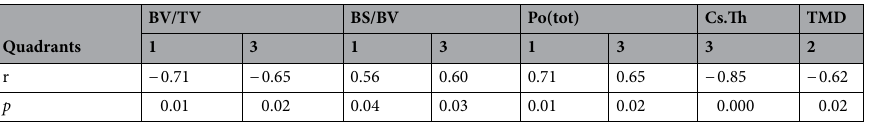
Table 4. Correlation between OA severity and microstructural parameters in all quadrants in cortical bone. BV/TV: bone volume fraction; BS/BV: specific bone surface; Po (tot): total porosity; Cs.Th: cortical thickness, TMD: tissue mineral density. The correlation coefficient, r, and p values are reported. p < 0.01 was considered significant.